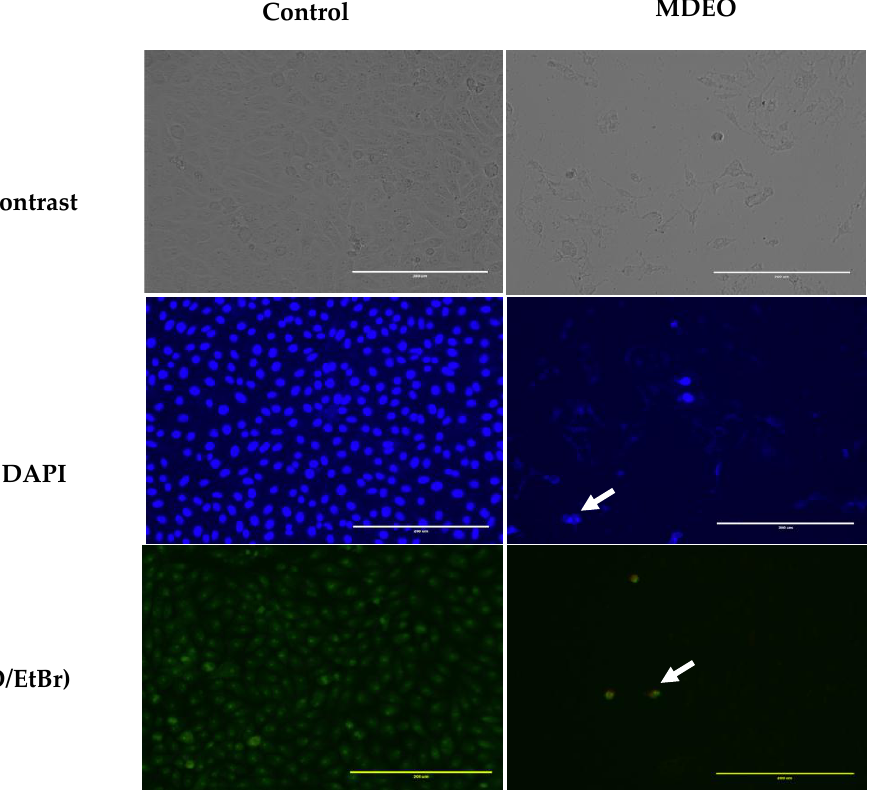
Figure 3. Detection of apoptosis by phase contrast and fluorescence microscopy in cells after treatment with MDEO. MCF-7 cells were treated with IC 50 for 24 h. Cells were stained with DAPI, acridine orange, and ethidium bromide (AO/EtBr).